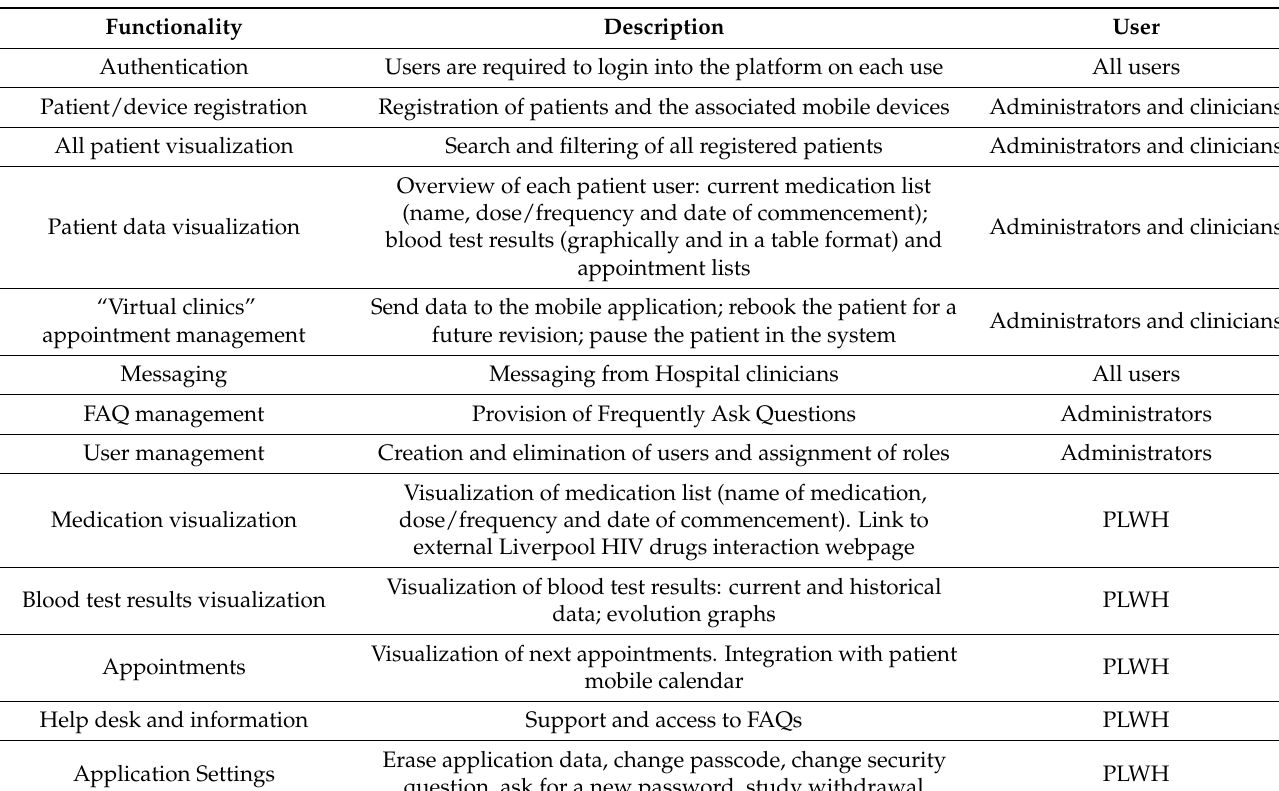
Table 1. Summary of the main EmERGE platform functional requirements. PLWH: people living with HIV. Functionality Description User